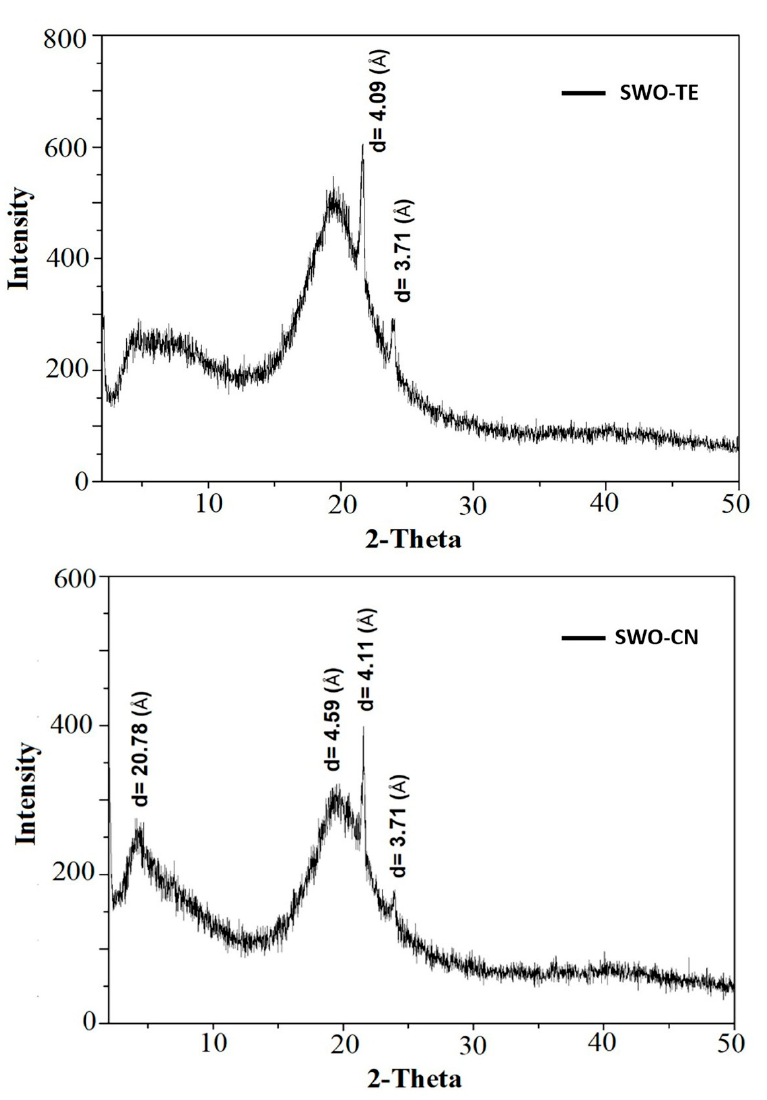
Figure 1. The X-ray diffraction patterns of the oleogel samples (SWO-TE: sunflower wax oleogel with thyme, SWO-CN: sunflower wax oleogel with cumin).